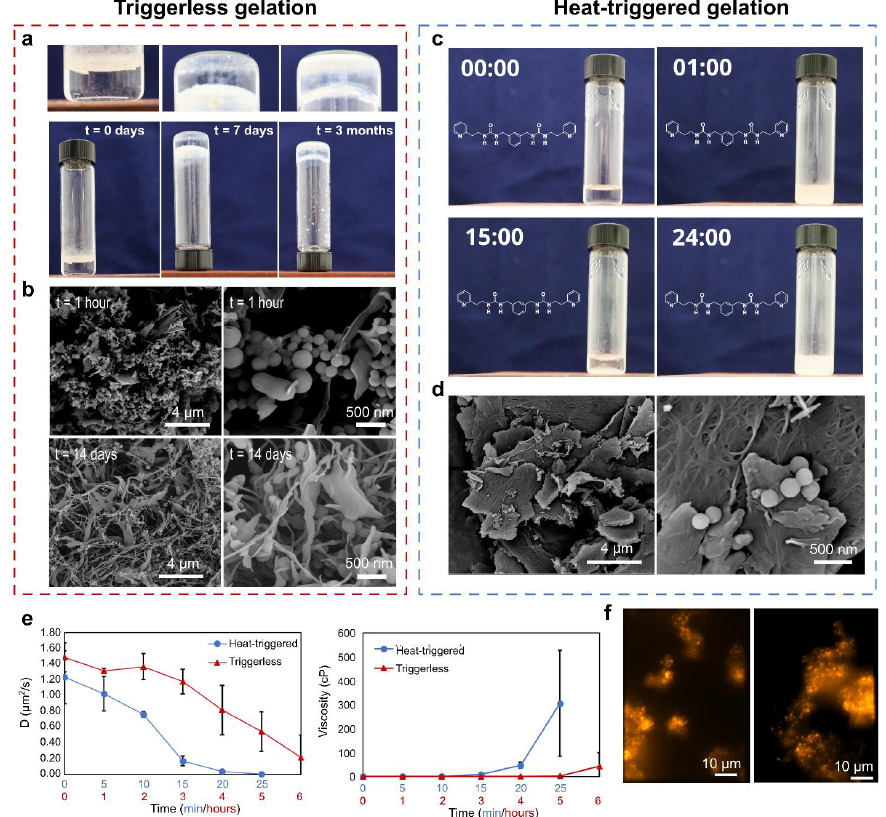
Figure 1. p2 o 1 spontaneously immobilizes water when added to the medium. ( a ) A stable self- supporting supramolecular hydrogel of p2 o 1 was formed by simply combining the gelator with water (1.0% w / v , 1 mL), without the need for an external trigger. Over time, the opacity of the sample increased. ( b ) Back-scattered electron images of the xerogel obtained without a trigger and by quenching the sample after 1 h or 14 days. A red scale bar (4 µ m or 500 nm) is provided at the bottom right of each image. ( c ) Frames of MV_S1 at t = 0 min, 1 min, 15 min, and 24 min following the heat-triggered gelation mechanism. At t = 0 min, the sample ( p2 o 1 in water at a concentration of 1.0% w / v ) was removed from a copper heating block set at 100 ◦ C and placed on the bench with the environment temperature of 22 ◦ C. ( d ) Back-scattered electron images of the xerogel obtained by a heat-trigger. A red scale bar (4 µ m or 500 nm) is provided at the bottom right of each image. ( e ) Evolution of the particle diffusion coefficient (D) and medium viscosity during heat-triggered (blue) and triggerless (red) gelation obtained using single particle tracking experiments. The x-axis value of the heat-triggered gelation ranged from 0 to 25 min, while for the triggerless gelation, the x-axis value ranged from 0 to 6 h. Results were averaged over three independent measurements and accompanied by their standard deviation. All samples were prepared at a concentration of 1.0% w / v . ( f ) After gelation, beads clustered together. Images of 200 nm diameter beads were acquired using a multiplane widefield microscope, after triggerless gelation had taken place. A scale bar of 10 µ m is provided at the bottom of each image. The two presented images were taken from the same sample at different